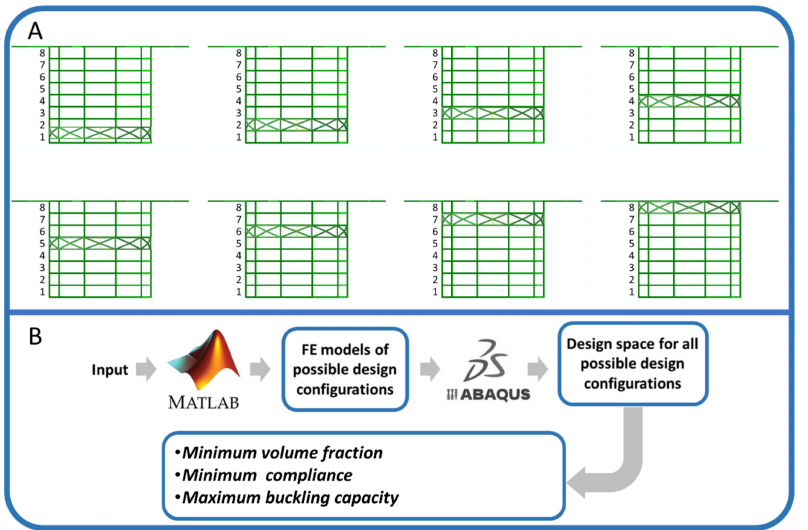
Figure 8. ( A ): Different locations of a helideck structure with 8 sections and 1 section of diagonal bracing. Different location of diagonal beams results in different compliances and buckling capacities. ( B ): The flowchart of the design space generation.